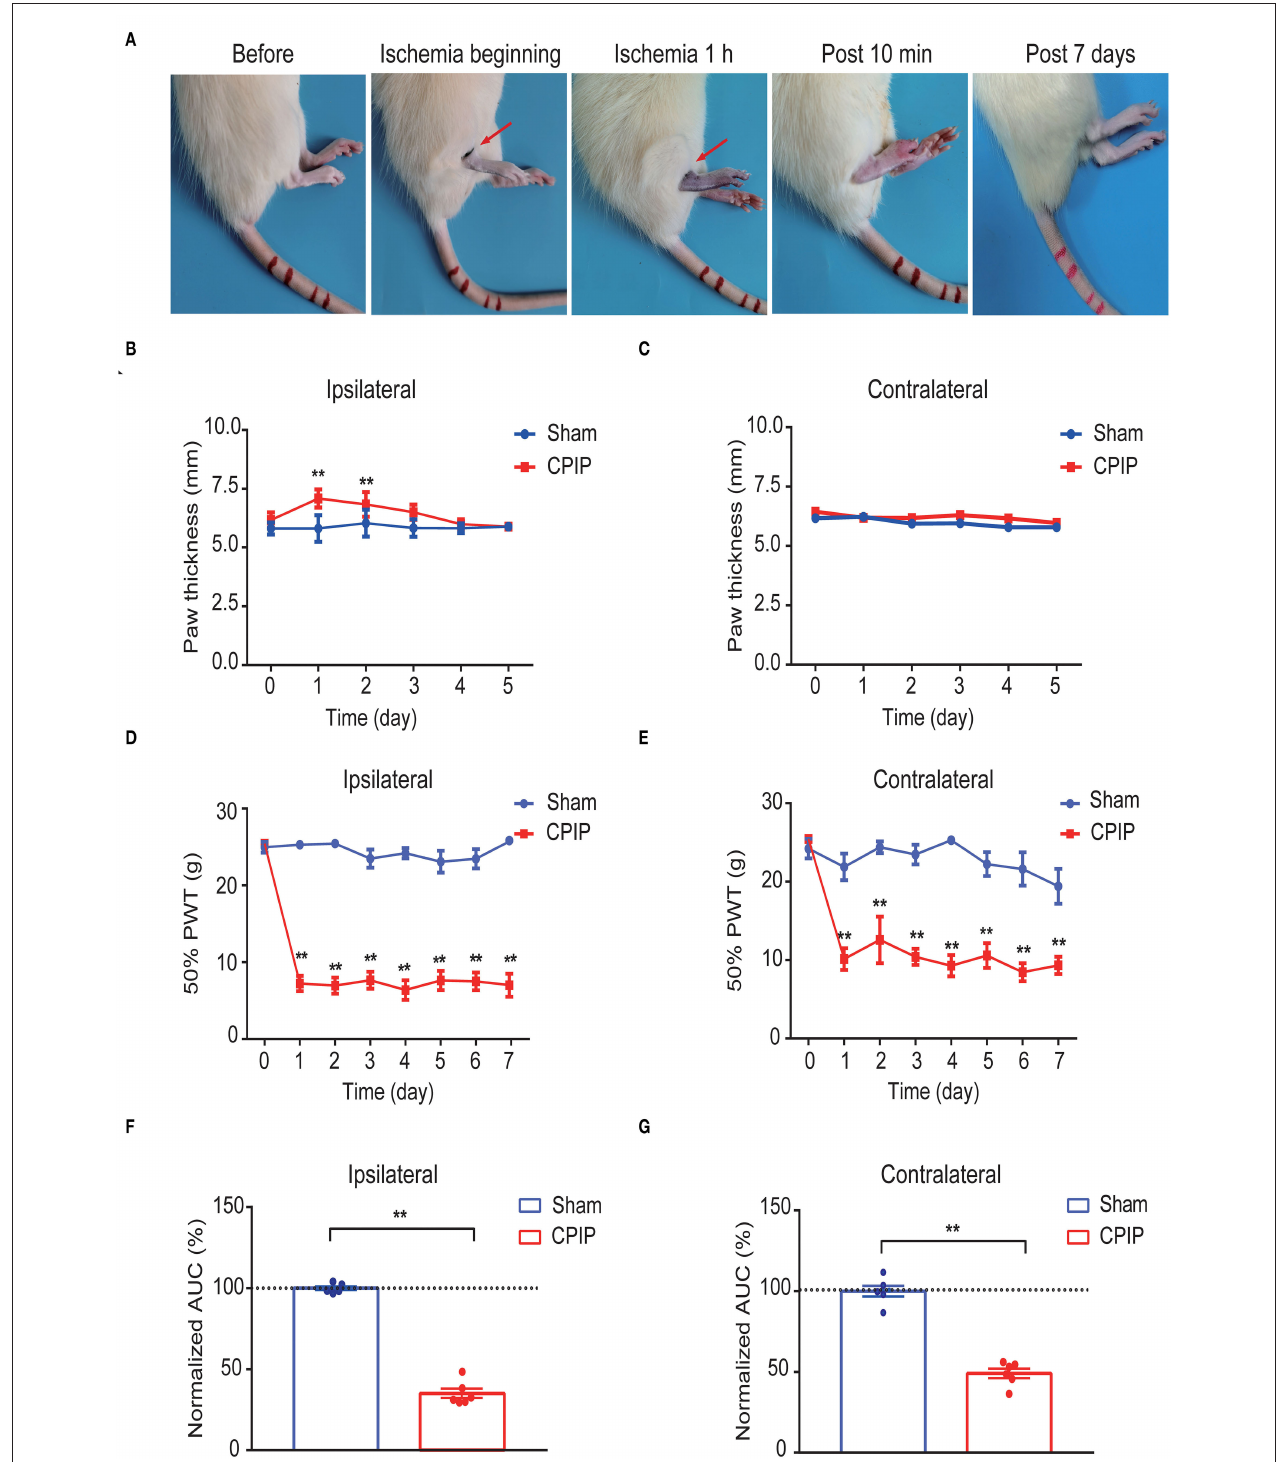
FIGURE 1 | The establishment of the rat CPIP model to mimic CRPS-I and nocifensive behavior evaluation. (A) Representative pictures showing the changes of the hind paw after the O-ring ligation at different time points as indicated. The red arrow indicates the position of the O-ring. (B,C) Ipsilateral (B) or contralateral (C) hind paw swelling after model establishment. (D,E) 50% paw withdraw threshold of ipsilateral (D) or contralateral (E) hind paw from sham and CPIP model rats after model establishment. (F,G) Normalized area under the curve calculated from (D) and (E) , respectively. n = 6 rats/group. ** p < 0.01 vs. Sham group. Two-way ANOVA with Tukey’s post-hoc test was applied in (B–E) . One-way ANOVA with Tukey’s post-hoc test was applied in (F,G) .